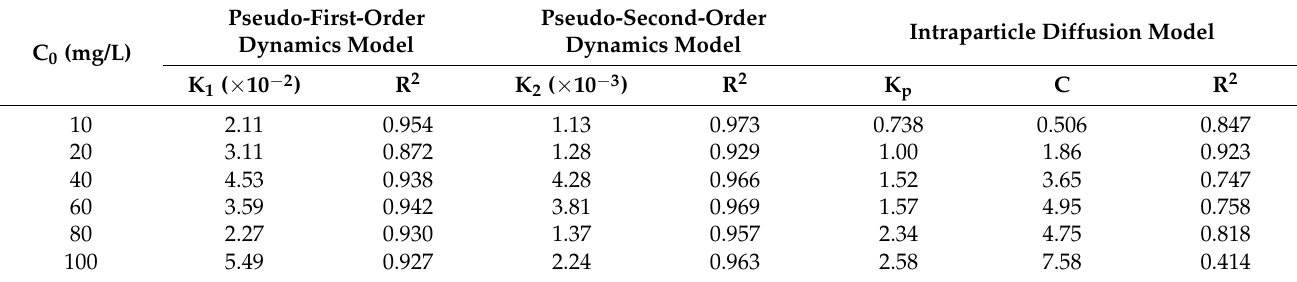
Table 3. Fitting data of the adsorption kinetics of MCM-48-SH at different concentrations. C 0 (mg/L)